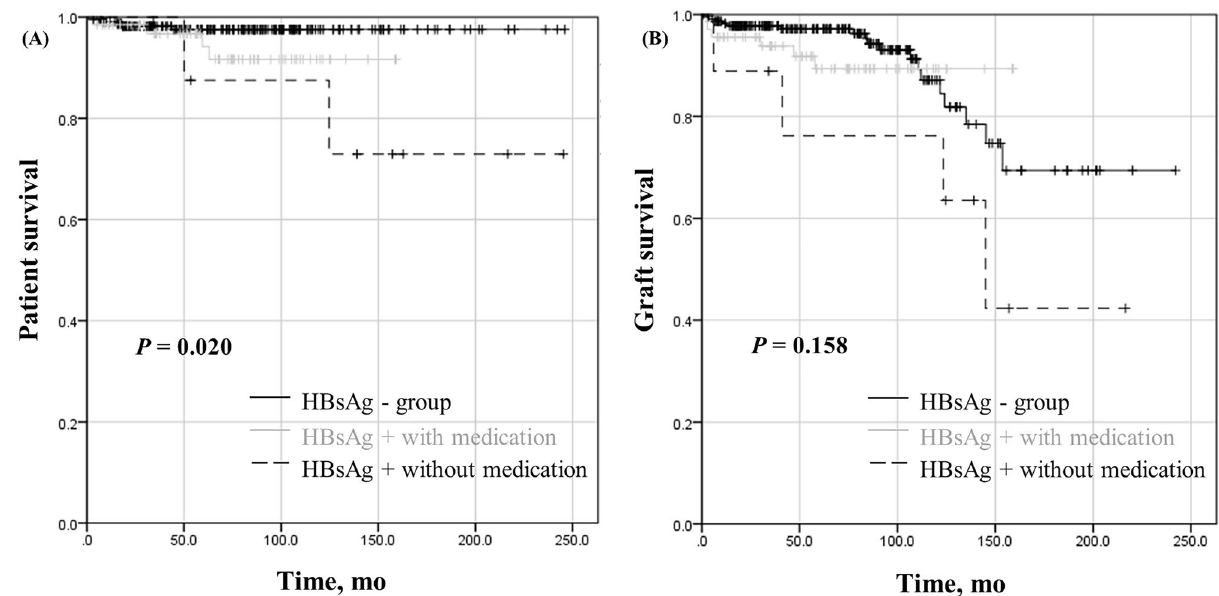
Figure 2. Kaplan–Meier curve for ( A ) patient survival and ( B ) graft